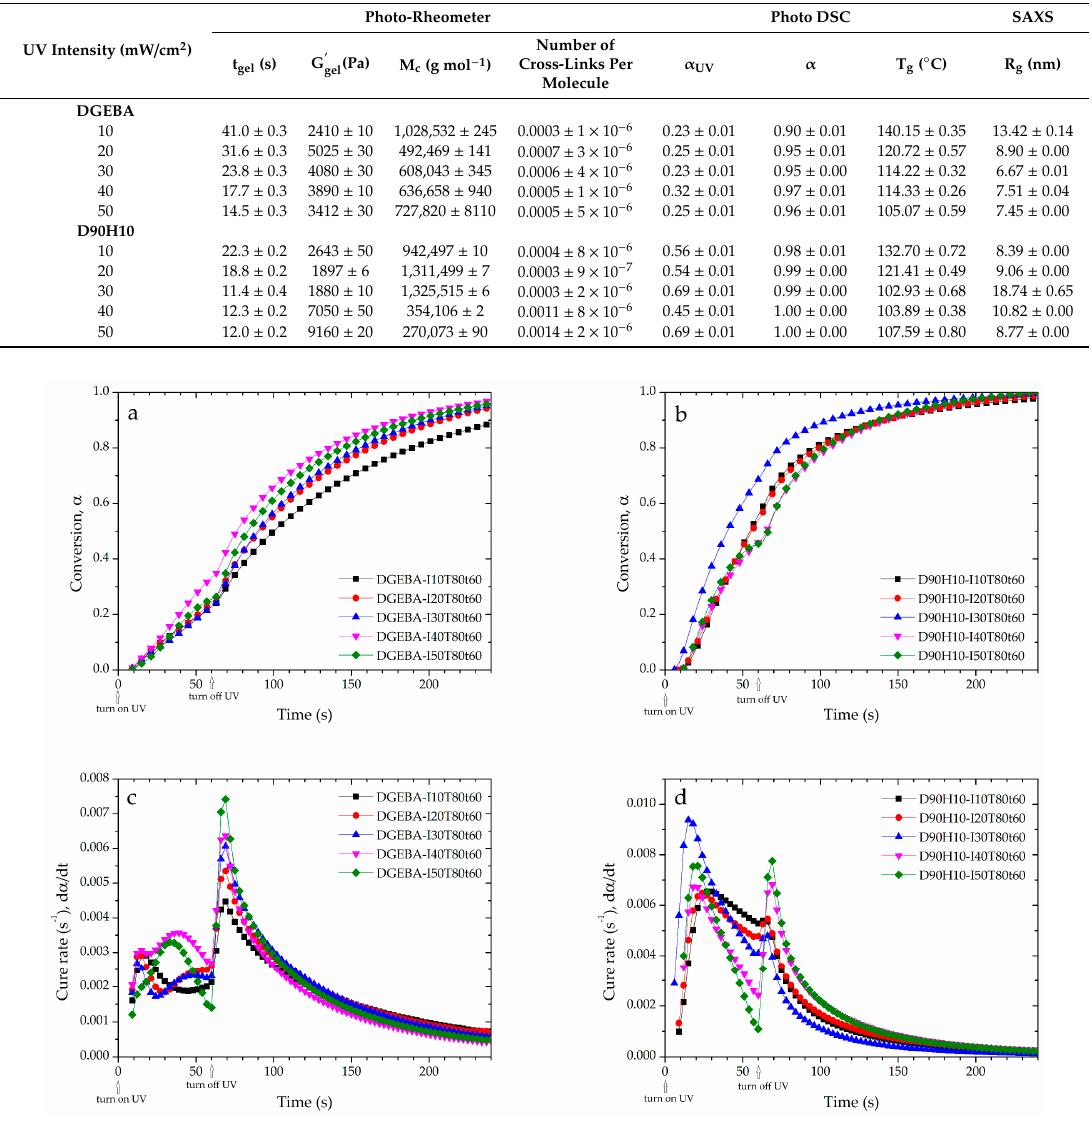
Figure 5. Conversion of ( a ) DGEBA and ( b ) D90H10, and cure rate of ( c ) DGEBA and ( d ) D90H10 with various UV intensity, the temperature of 80 °C and irradiation time of 60 s. Table 2. The properties of DGEBA and D90H10 systems at various UV intensity.